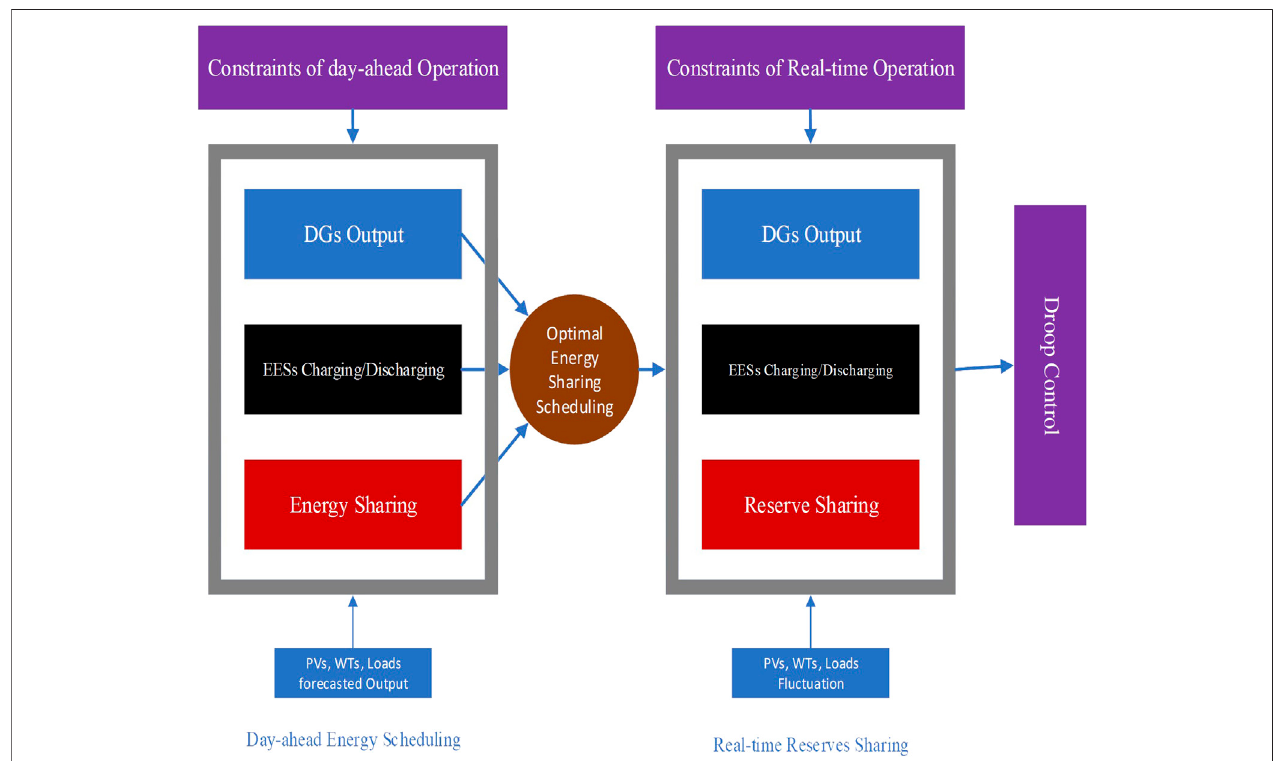
FIGURE 2 | Energy sharing and reserve sharing of isolated